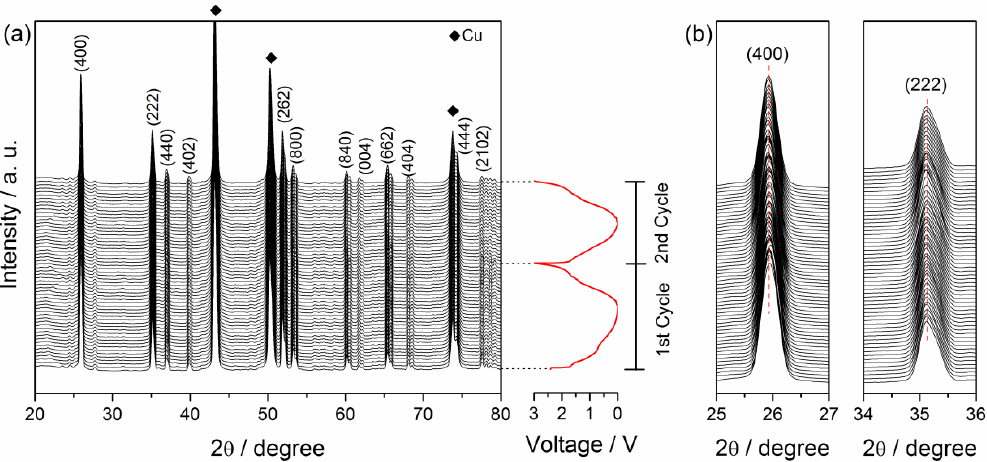
Figure 2. ( a ) In situ X-ray diffraction patterns collected during the charge and discharge of pristine NbO 2 at 0.05 C and ( b ) expansion of the above patterns around the (400) and (222) peaks.